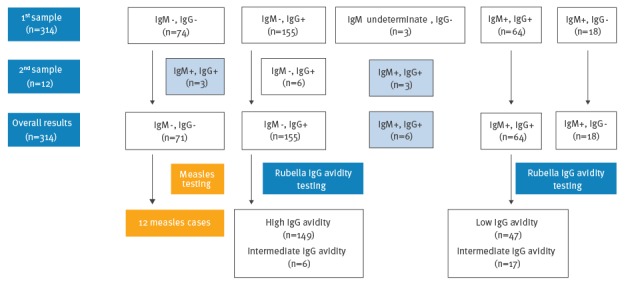
Serological testing of pregnant women with clinical symptoms of rubella or exposed to rubella, Romania, September 2011–December 2012 (n=314)